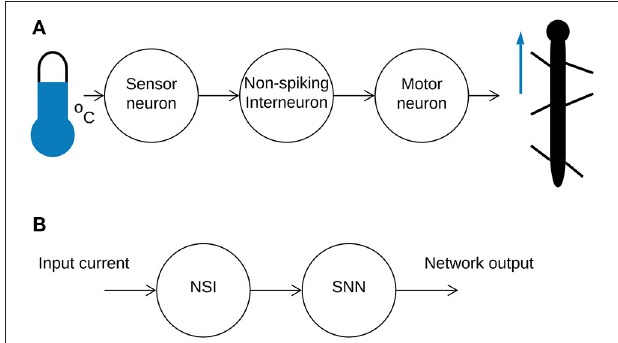
FIGURE 1 | (A) An illustration of a simplified sensorimotor neuron pathway. A signal is received from the outside world and sent onwards from the sensor neuron to the NSI through current injection. The NSI passes the information onto the motor neuron to generate movement. (B) A high-level overview of the mixed neural network combining an NSI and